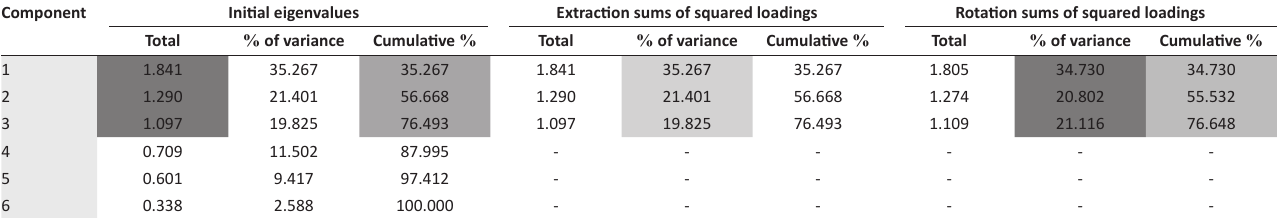
TABLE 7: Component total variance explained.